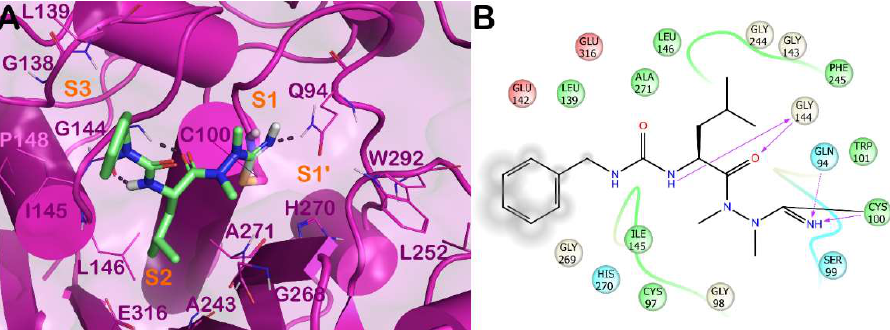
Figure 9. ( A ) Crystal structure of Lm CPB (cyan cartoon) in complex with 32 (yellow sticks) (PDB ID 6P4E). Interacting residues within the binding site are represented by lines, and the covalent bond established by Cys26 is represented by a stick. H bonds are illustrated by grey dotted lines. For the sake of clarity, water molecules are removed, and the complex was treated by the protein preparation wizard module available in Maestro (Maestro, Schrödinger LLC, release 2020-3). The picture was generated by PyMOL (The PyMOL Molecular Graphics System, v1.8; Schrödinger, LLC, New York, NY, USA, 2015). ( B ) Detailed interaction diagram of compound 32 within the Lm CPB binding site, as provided by the ligand interaction diagram available in Maestro (Maestro, Schrödinger LLC, release 2020-3).